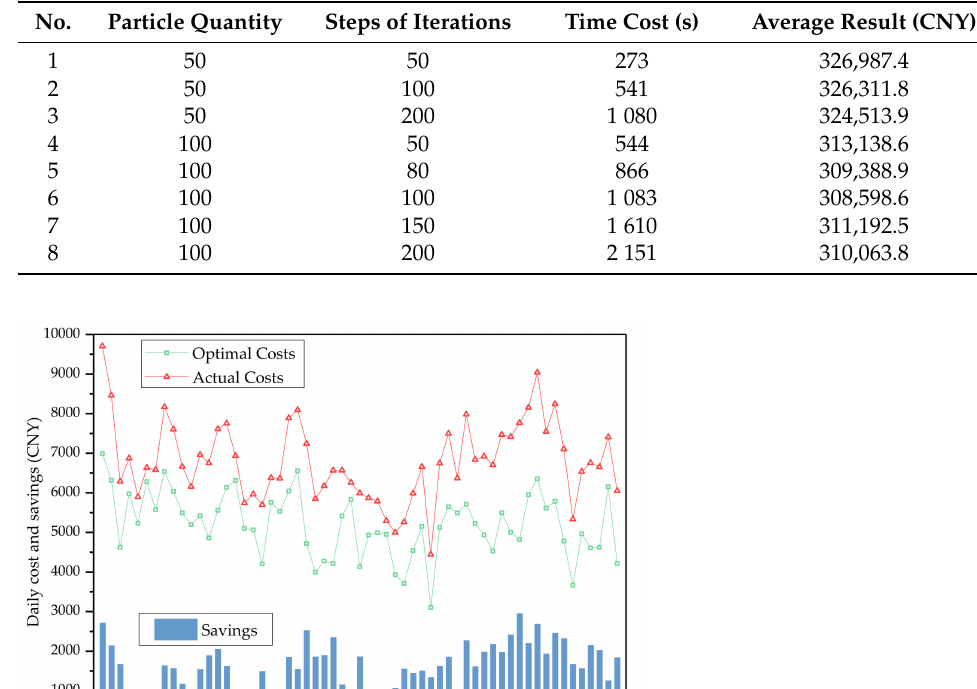
Table 6. Average results of various iteration sizes.